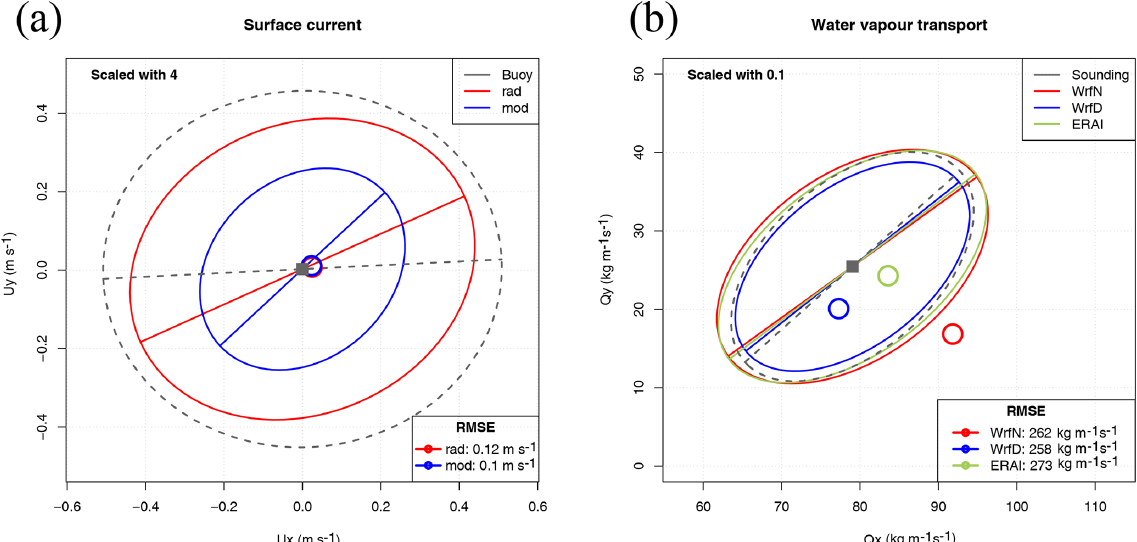
Figure 6. Sailor diagram representing the structure of errors between HF radar estimations of currents (rad) and model results (mod) with variances corresponding to EOFs scaled with a scale factor of 4 (a) . Sailor diagram derived from vertically integrated water vapour trans- port (b) with a scale factor of 0.1. Table 2. Agreement of simulations by different models with observed vertically integrated water vapour transport from soundings. σ x and σ y represent the semi-major and semi-minor axes of the ellipses (kgm − 1 s − 1 ). The R 2 column represents the value of the two-dimensional correlation coefficient following Crosby et al. (1993) ( R 2 = 2 for a perfect model). The differences between the datasets described by the bias | U − V | (kgm − 1 s − 1 ) and total root mean squared error (kgm − 1 s − 1 ) are also shown. Finally, the eccentricity of the ellipses ( ε ) and the congruence coefficient g 11 of the EOF1 of every model with the one derived from observations are also shown. The congruence coefficient g 11 represents the absolute value of the cosine of the relative rotation of model ellipses with respect to the observational one (Sect. 3.2).